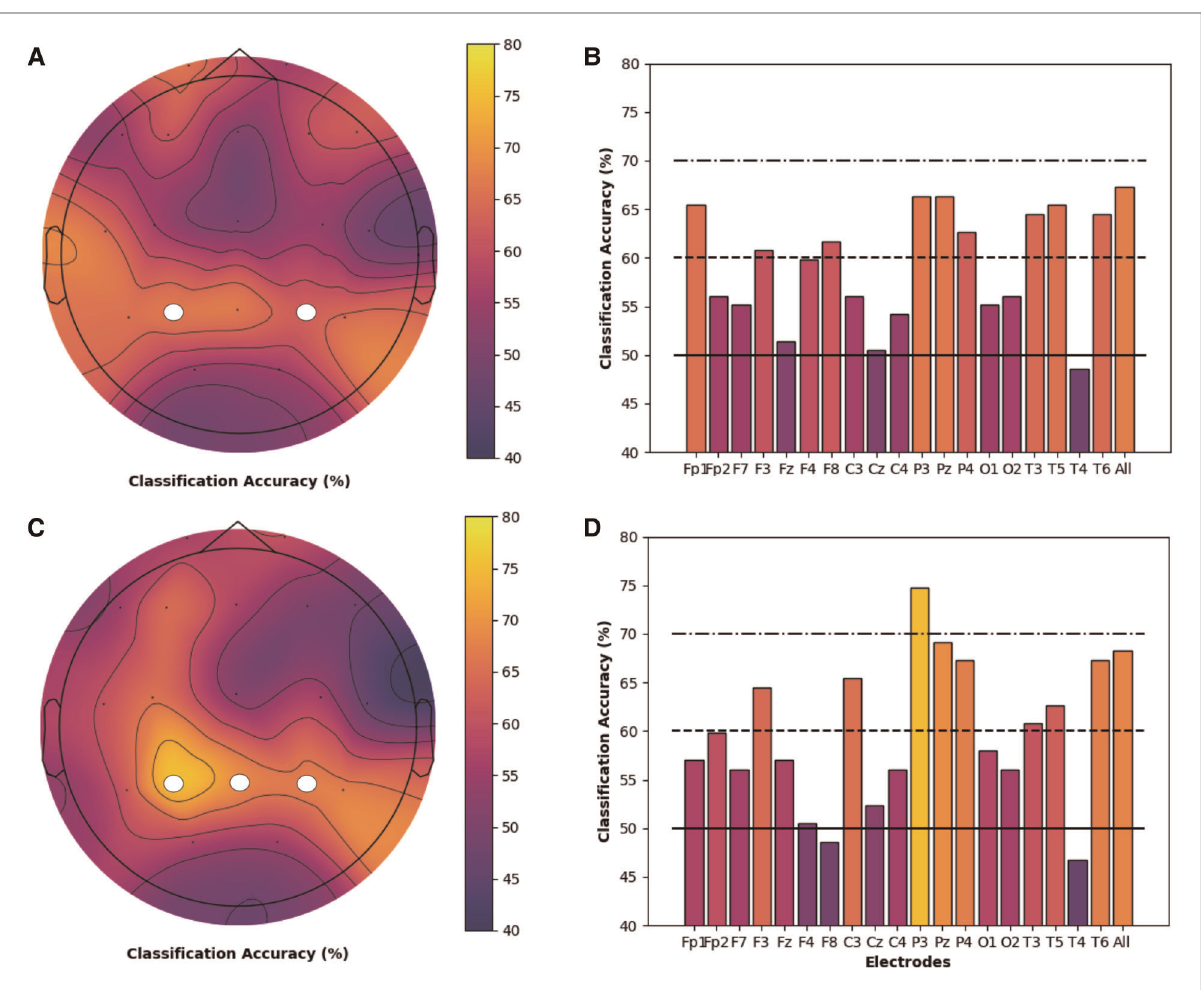
FIGURE 4 Individual electrode classi fi cation accuracy for health controls permutation entropy features (theta frequency band) . Pain vs. no pain classi fi cation accuracy for each individual electrode and across all electrodes for PE (theta band) features only in healthy participants. Topographic maps and bar charts are displayed for SVM models ( A & B ) and logistic regression models ( C & D ). White circles designate electrodes where models in healthy participants had signi fi cantly higher classi fi cation accuracy than chronic pain